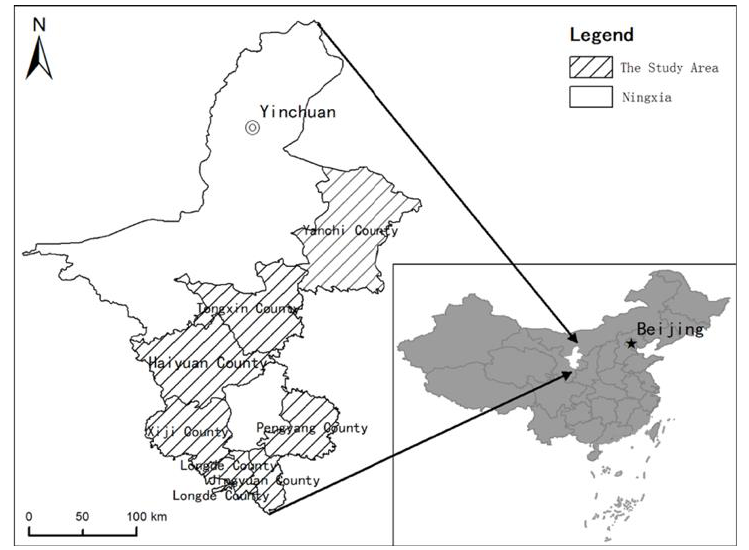
Figure 1. Location of the research area.